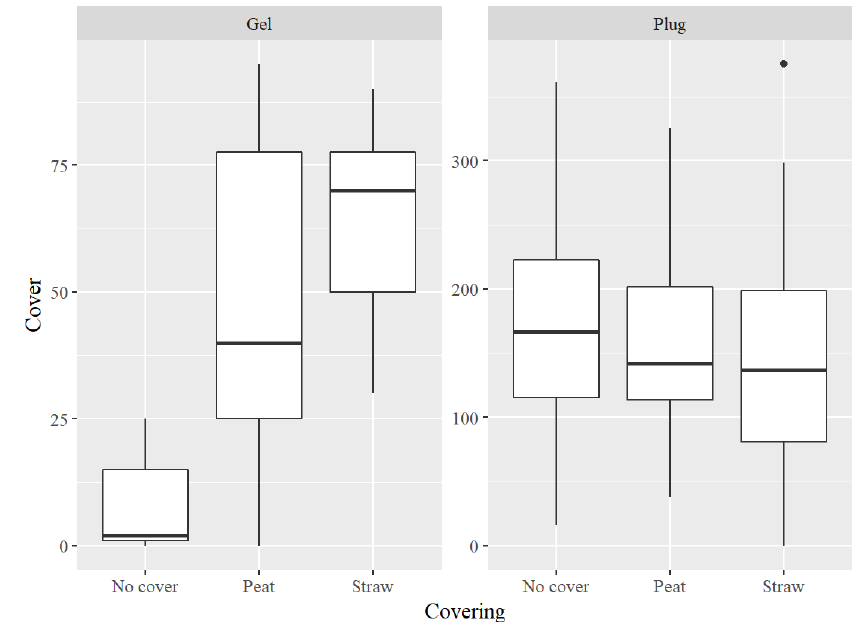
Figure 9. Sphagnum cover (% and cm 2 , respectively) 18 months after application of BeadaGel™ (left) and BeadaHumok™ (right, initial plug size was 10.2 cm 2 ) comparing plots with peat, straw or no mulch (Trial D). The Sphagnum was planted in December 2014 on lowland peatland after site re-wetting and spontaneous growth of E.